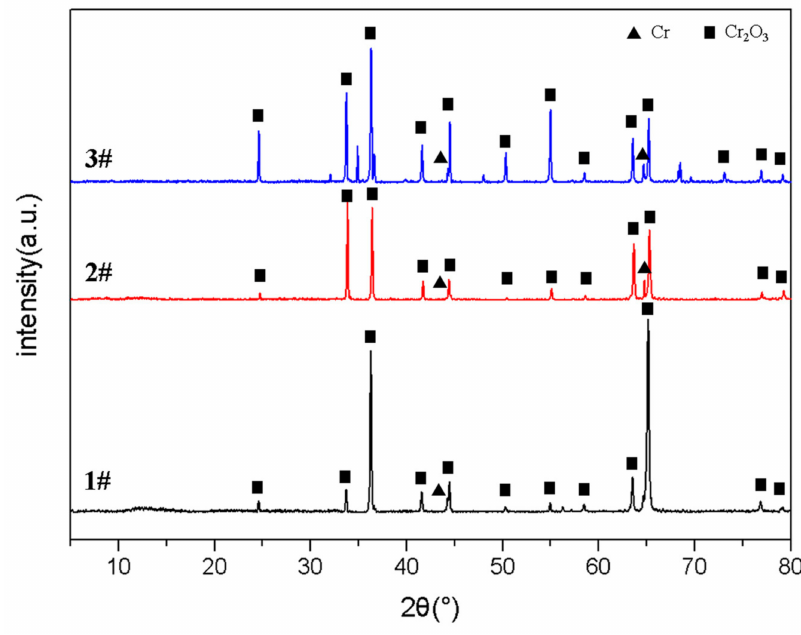
Figure 7. XRD patterns of three coating samples after oxidation at 1200 ◦